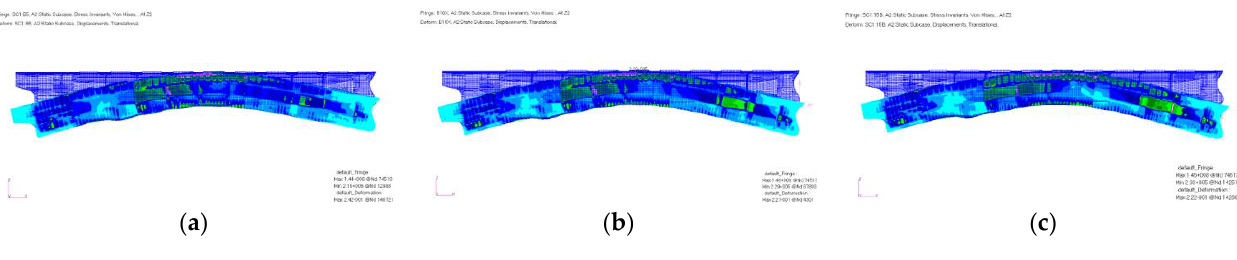
Figure 3. Ship deformation at t = 0.125 T. ( a ) 5 kn; ( b ) 10 kn; ( c ) 15 kn.